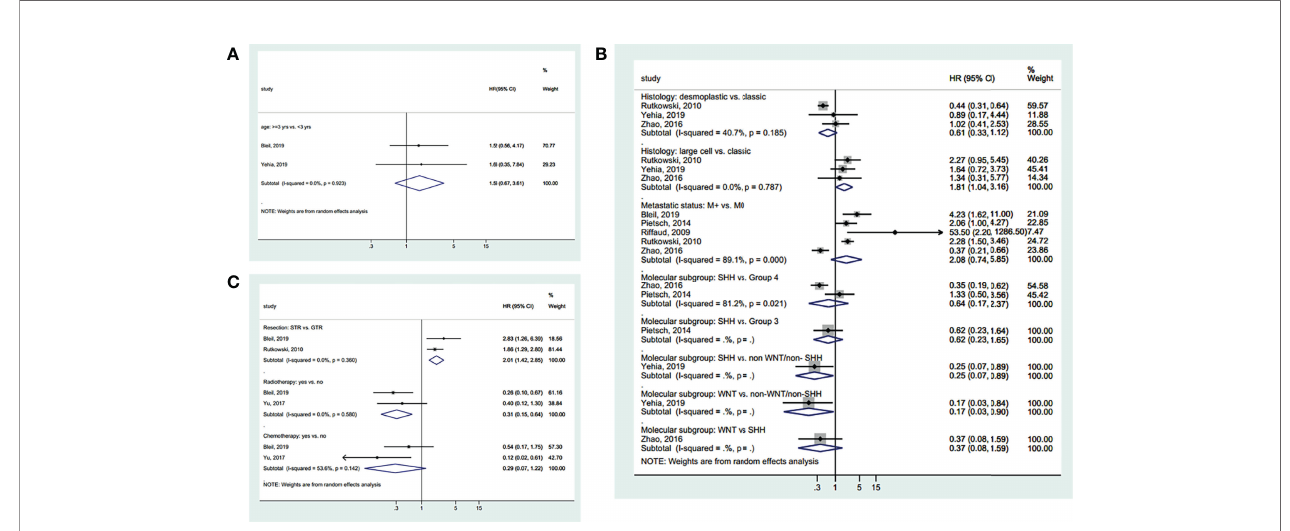
FIGURE 4 | Forest plots of the prognostic factors and event-free survival (EFS). (A) Demographic characteristics. (B) Clinical characteristics. (C) Treatment